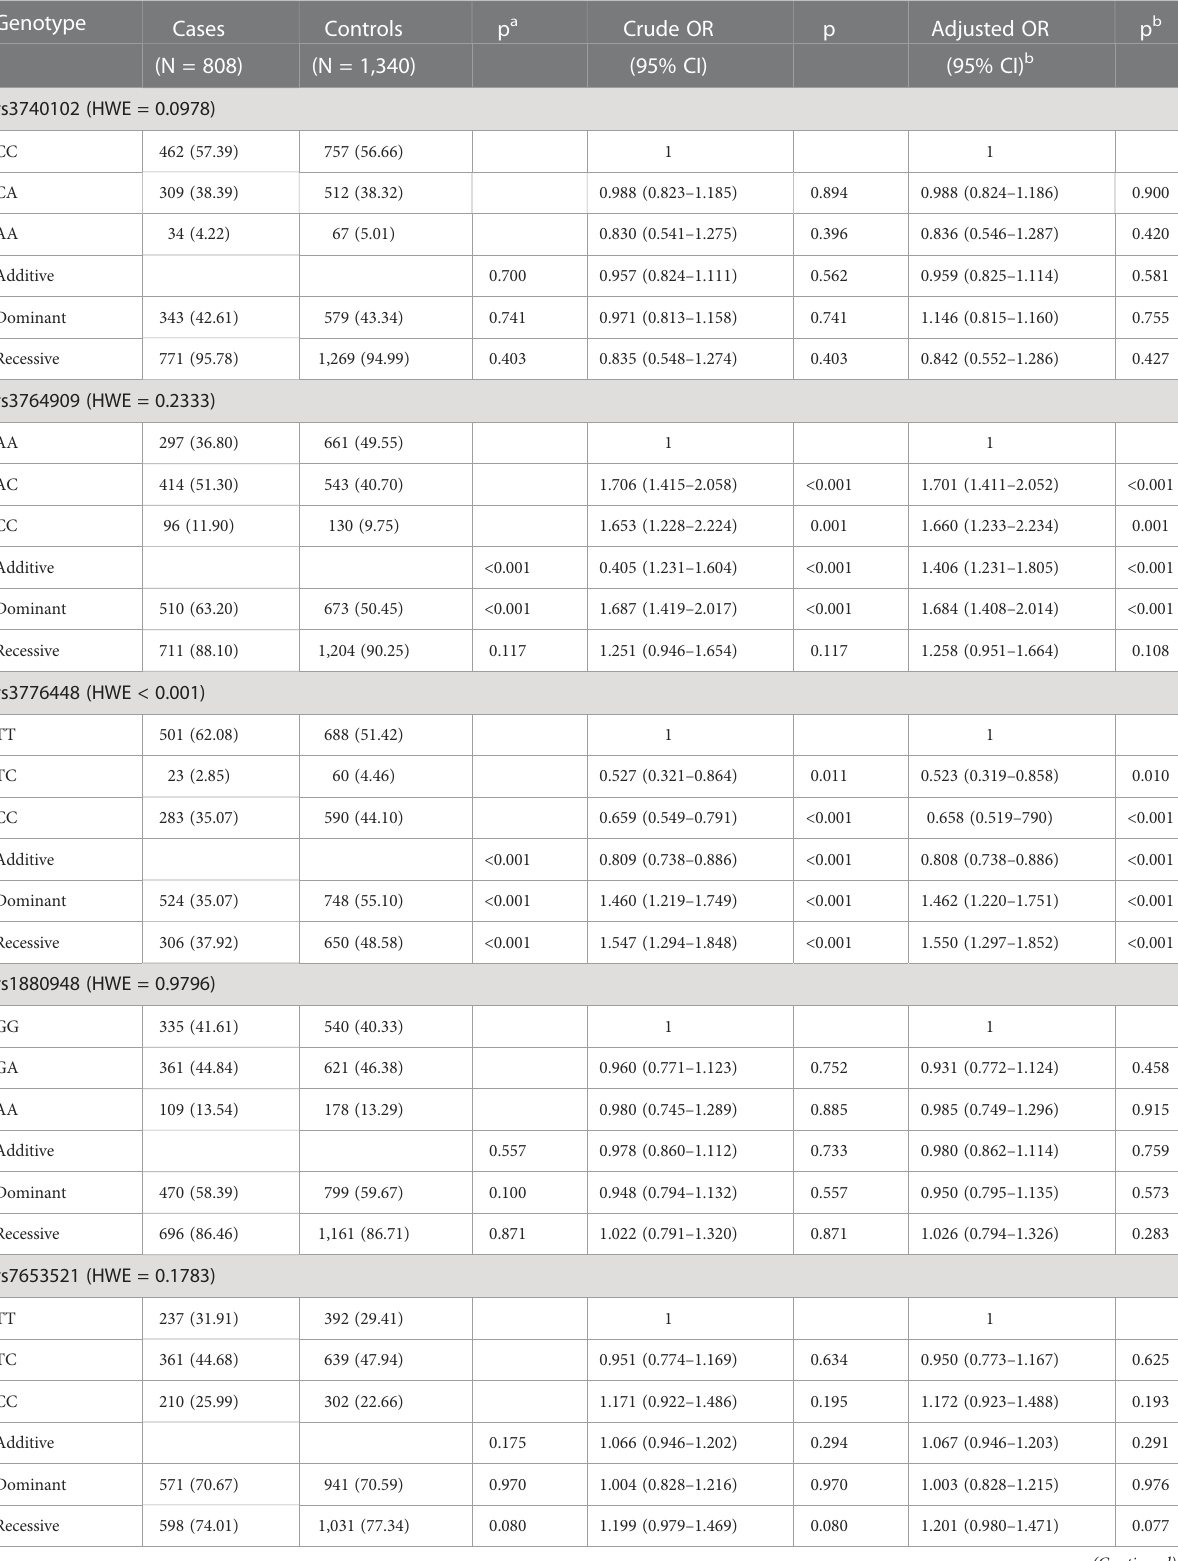
TABLE 1 Logistic regression analysis of associations between m5C modi fi cation key gene polymorphisms and ALL